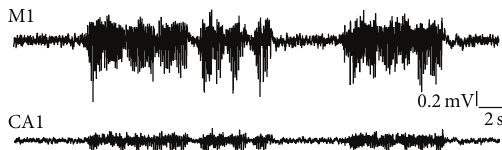
Figure 7: Radiotelemetric EEG recording in a rat model of mesial temporal lobe epilepsy. Limbic seizures are pharmacologically induced via a pilocarpine injection regime. This figure illustrates synchronous recording from the primary motor cortex (M1) as well as the hippocampal CA1 region from a rat at the age of 3 months. Ascending and descending spike/poly-spike trains are present in both